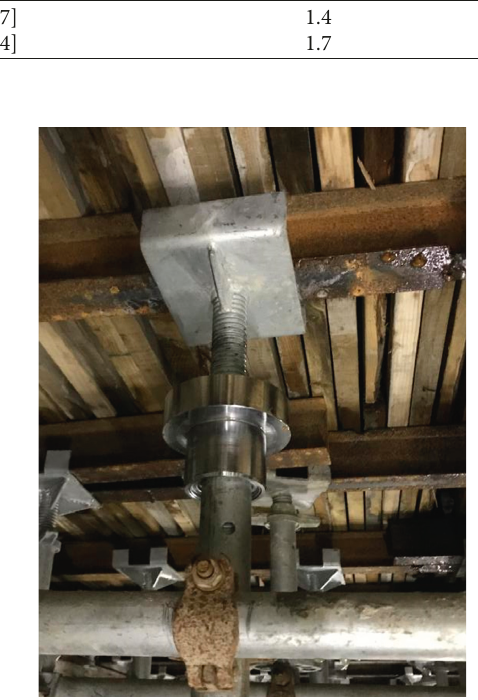
Figure 18: Test sensor for vertical pole’s axial force.